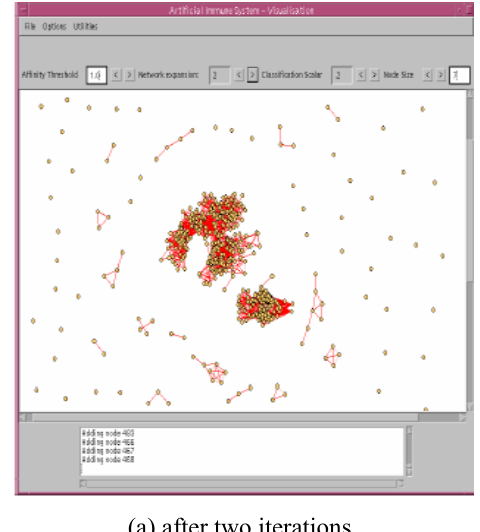
Figure 2. Interactions between antibody and antigen in natural immune